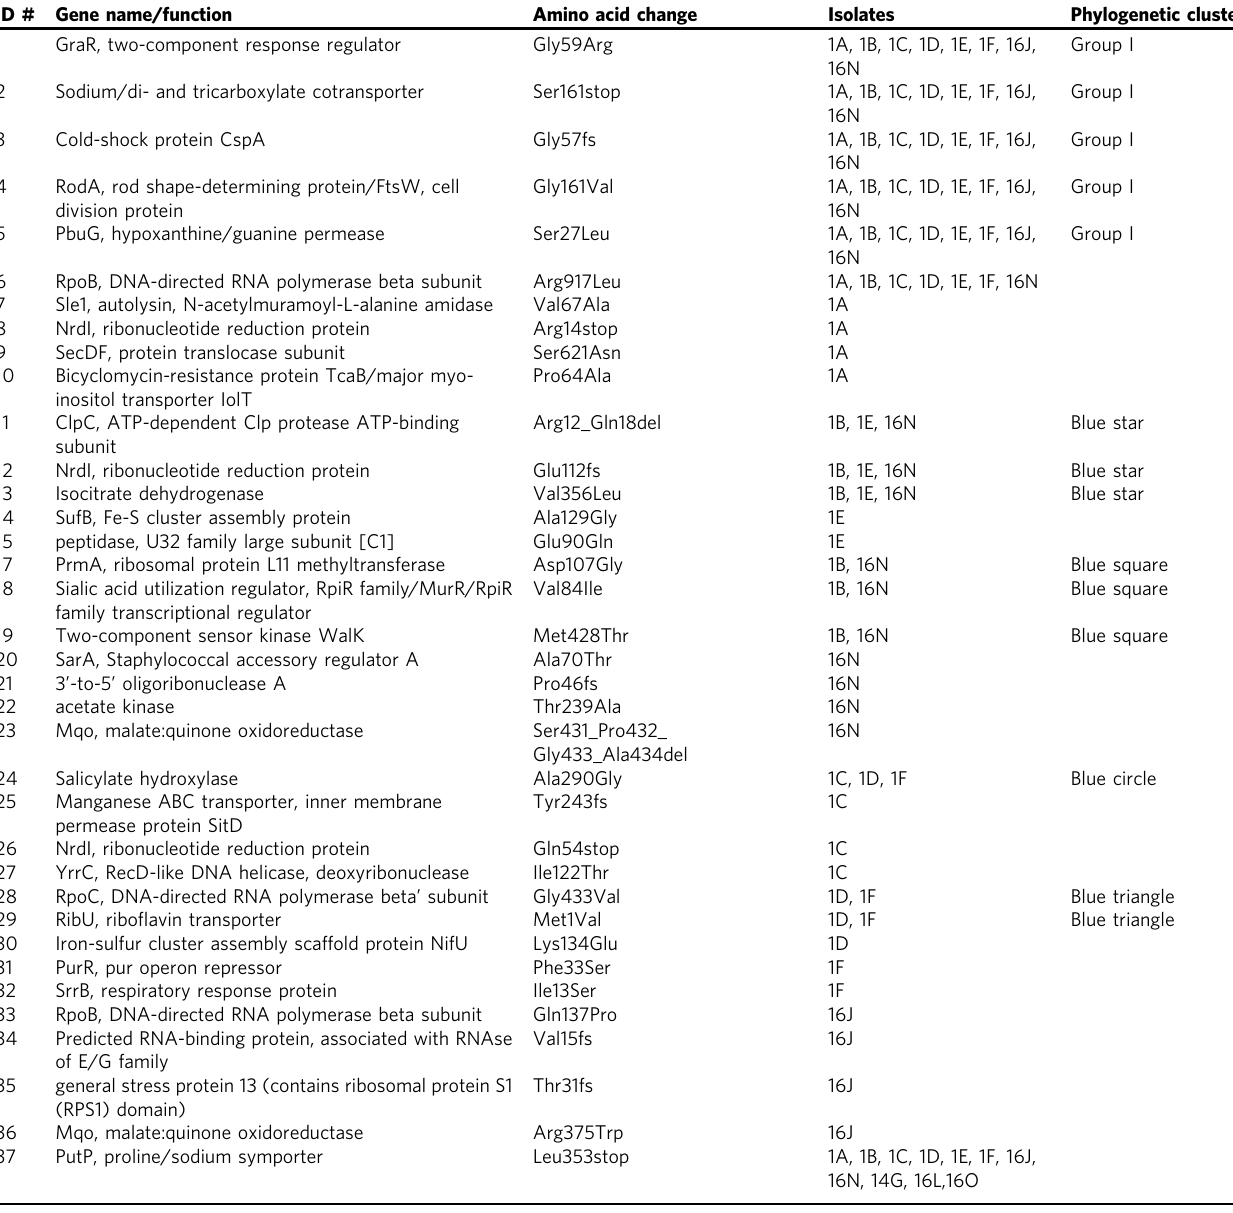
Table 2 Non-synonymous SNPs and InDels found in the group I clinical ST378 S. epidermidis